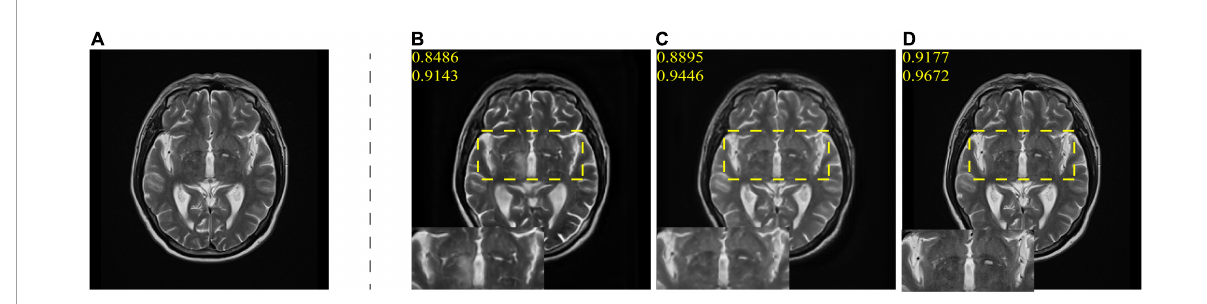
FIGURE6 (A) is the real T2 image; (B) is the T2 image generated with mask information; (C) is the T2 image generated with AN; and (D) is the T2 images generated with mask information and AN. The numbers in yellow represent the SSIM and FSIM scores of the generated images.